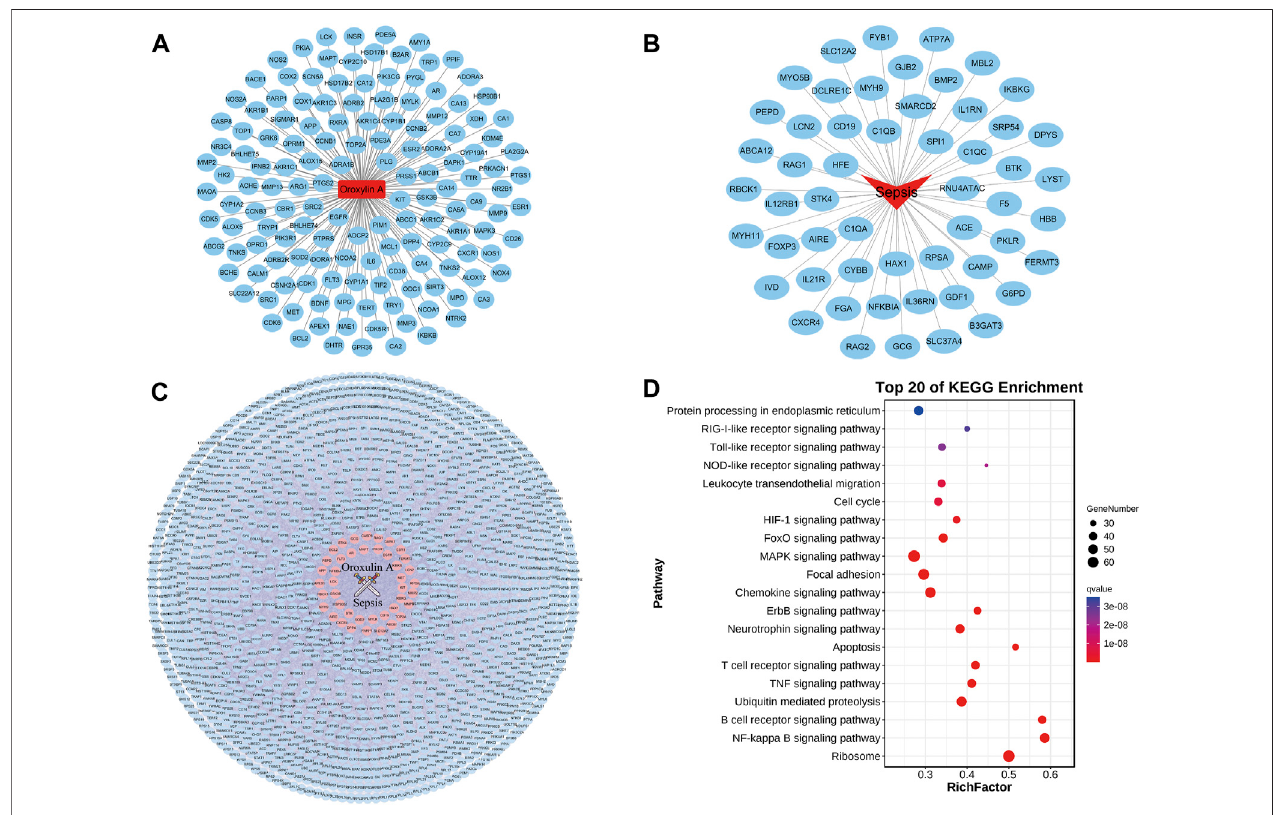
FIGURE 6 | Pathway prediction of oroxylin A treating on sepsis. (A) Potential targets screen of oroxylin A. (B) Related targets screen of sepsis. (C) Intersection of candidate targets between oroxylin A and sepsis. (D) KEGG enrichment analysis of oroxylin A in the treatment of sepsis.